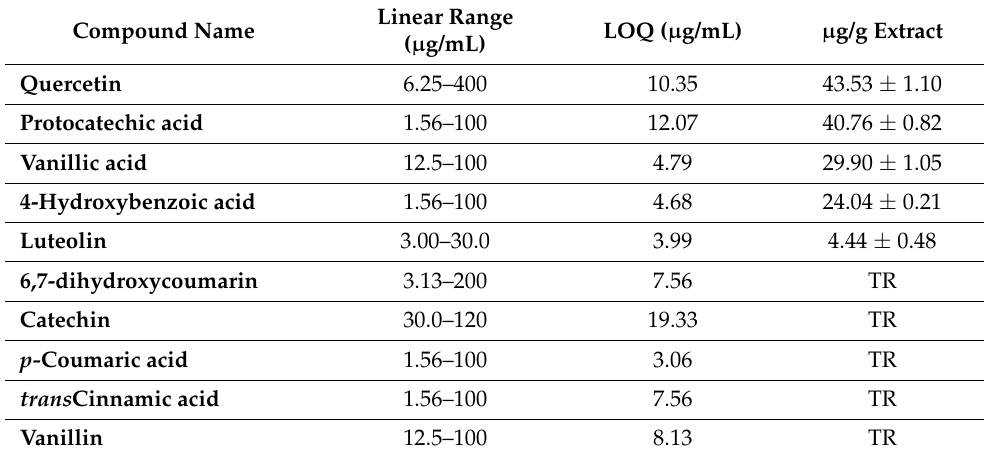
Table 1. Phenolic compounds detected in the propolis